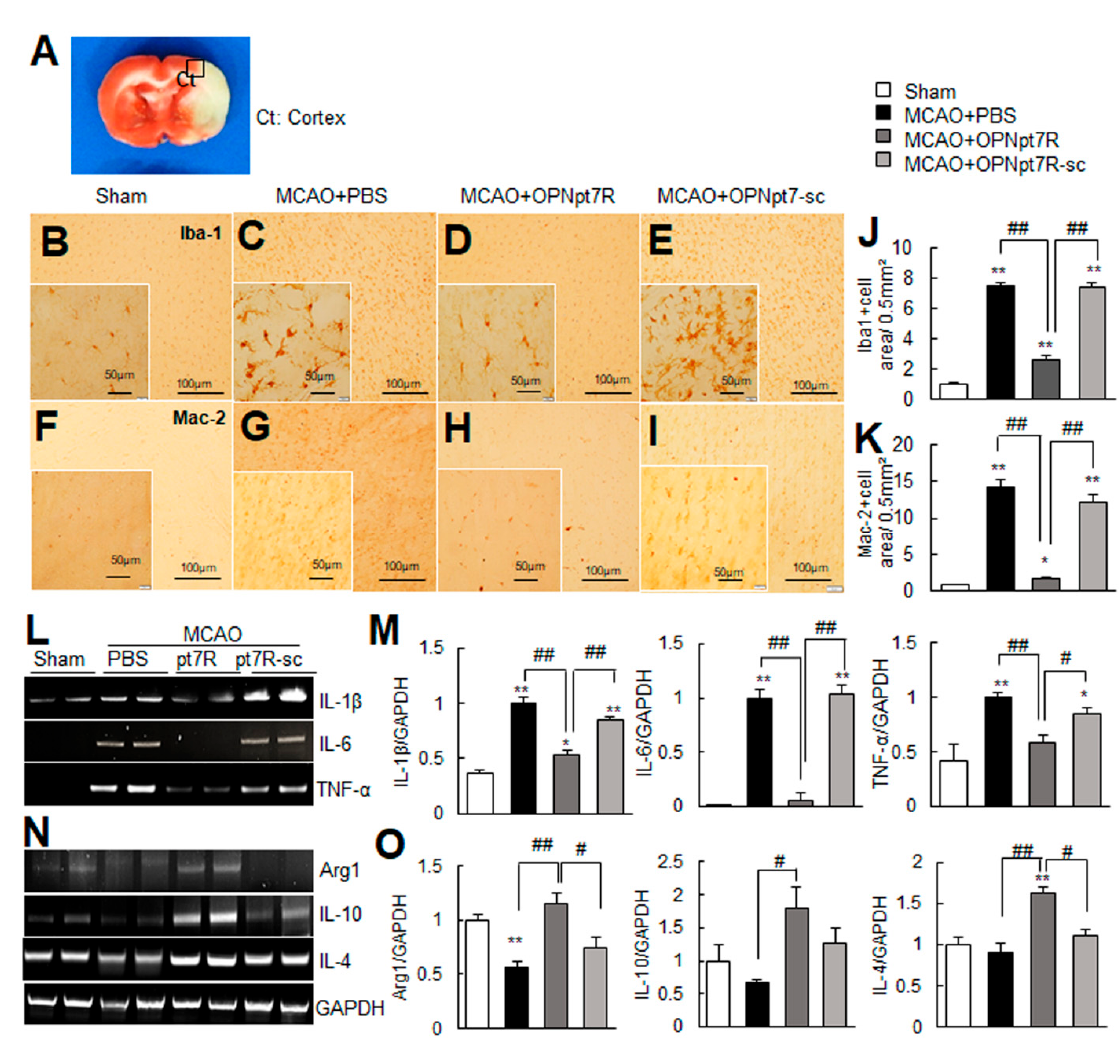
Figure 5. Anti-inflammatory effect of OPNpt7R in the post-MCAO brain; OPNpt7R (500 ng) or OPNpt7R-sc (500 ng) was administered intranasally 1 h post-MCAO. ( A – K ) Coronal brain sections were prepared from sham ( B , F ), MCAO ( C , G ), MCAO+OPNpt7R ( D , H ), and MCAO+OPNpt7R-sc ( E , I ) groups at 1 day after MCAO. Brain sections were processed for immunostaining with anti-Iba1 ( B – E ) or anti-Mac-2 ( F – I ) antibodies. Representative pictures from three independent experiments are presented ( B – E , F – I ), and the areas of Iba1 + or Mac-2 + cells in regions (0.5 mm 2 ) indicated black box in A were measured and are presented as means ± SEMs ( n = 12, 12 brain slices from three animals) ( J , K ). The insets are high-magnification photographs of each image. Scale bars in B-I represent 100 µm, and those in the insets represent 50 µm. ( L – O ) Samples were prepared from the indicated region in A at 1-day post-MCAO, and expression levels of pro- or anti-inflammatory markers were examined by RT-PCR. The results are presented as the mean ± SEM ( n = 3~4). Sham, sham-operated rats; MCAO, PBS-treated MCAO controls; MCAO+OPNpt7R, OPNpt7R-treated MCAO rats; MCAO+OPNpt7R-sc, OPNpt7R-sc-treated MCAO rats. * p < 0.05, ** p < 0.01 vs. PBS-treated MCAO controls, and # p < 0.05, ## p < 0.01 between indicated groups.